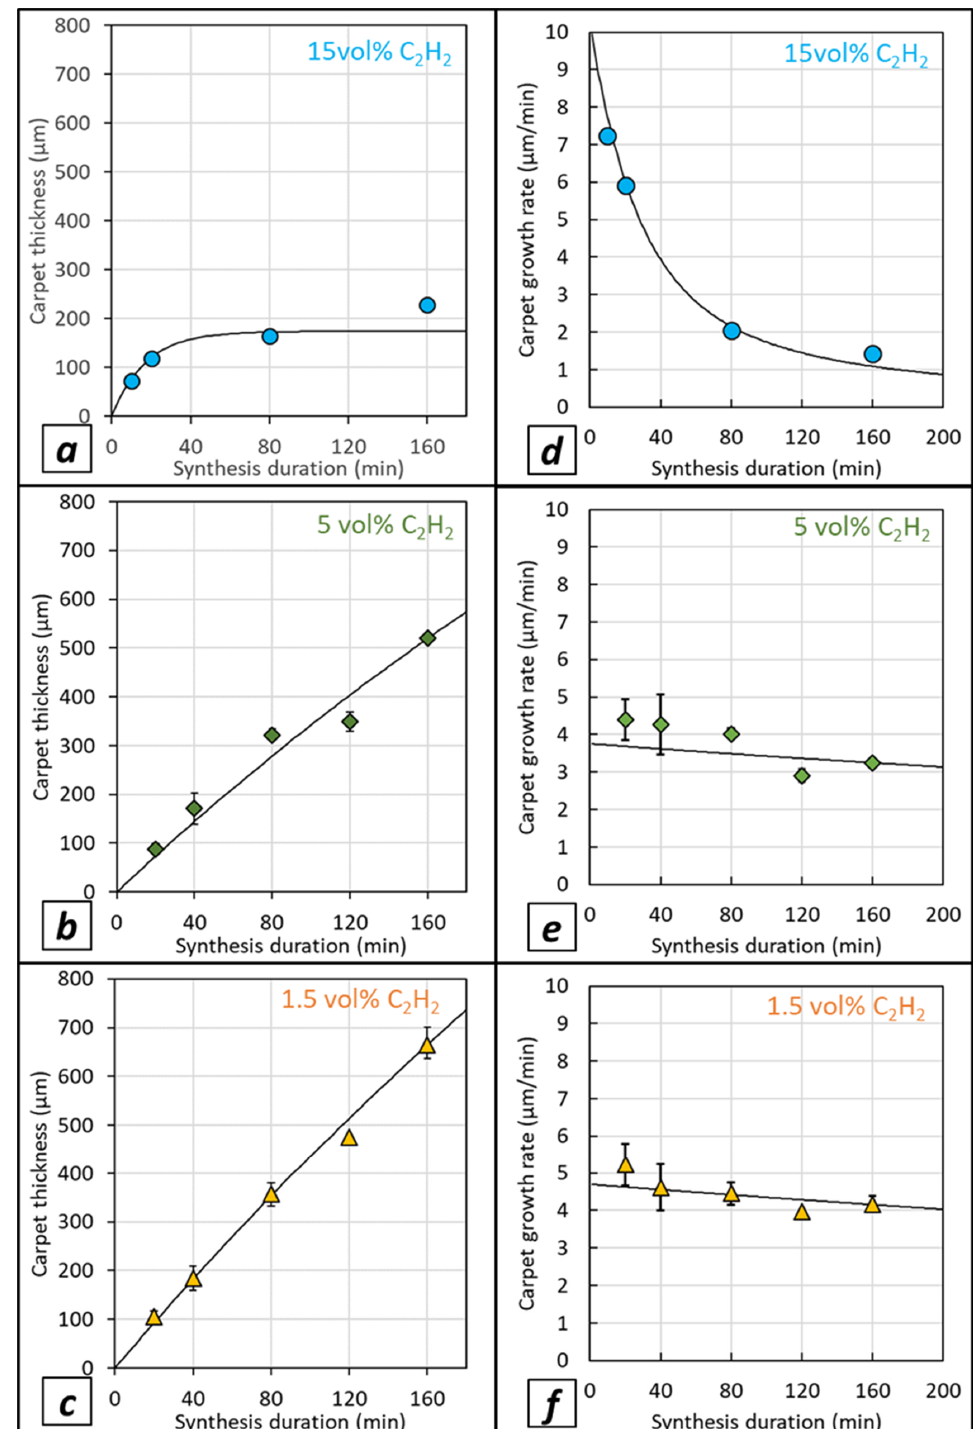
Figure 6. Carpet thickness versus synthesis duration on HG-Al substrates, for various acetylene volume contents in the gas phase: ( a ) 15 vol%, ( b ) 5 vol% and ( c ) 1.5 vol%. Exponential model fittings are also plotted (plain black lines). Growth rate versus synthesis duration for various acetylene volume contents in the gas phase: ( d ) 15 vol%, ( e ) 5 vol% and ( f ) 1.5 vol%. Experimental dots correspond to the mean values calculated from 4 measurements performed on the cross-section of VACNTs observed on Al discs (P5 for LG-Al and P6 for HG-Al) for at least one synthesis experiment and up to three synthesis experiments performed in the same conditions. The variation ranges indicated around mean values correspond to the minimum and maximum of the mean